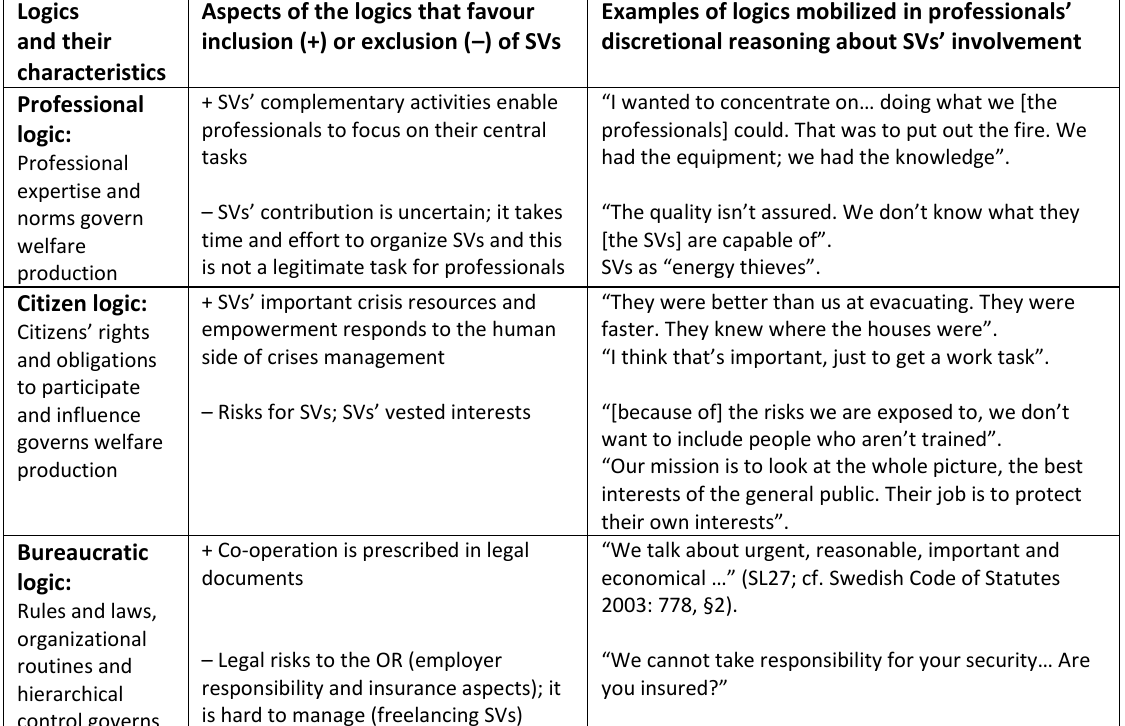
Table 1. Examples of logics being mobilized by professionals regarding SV